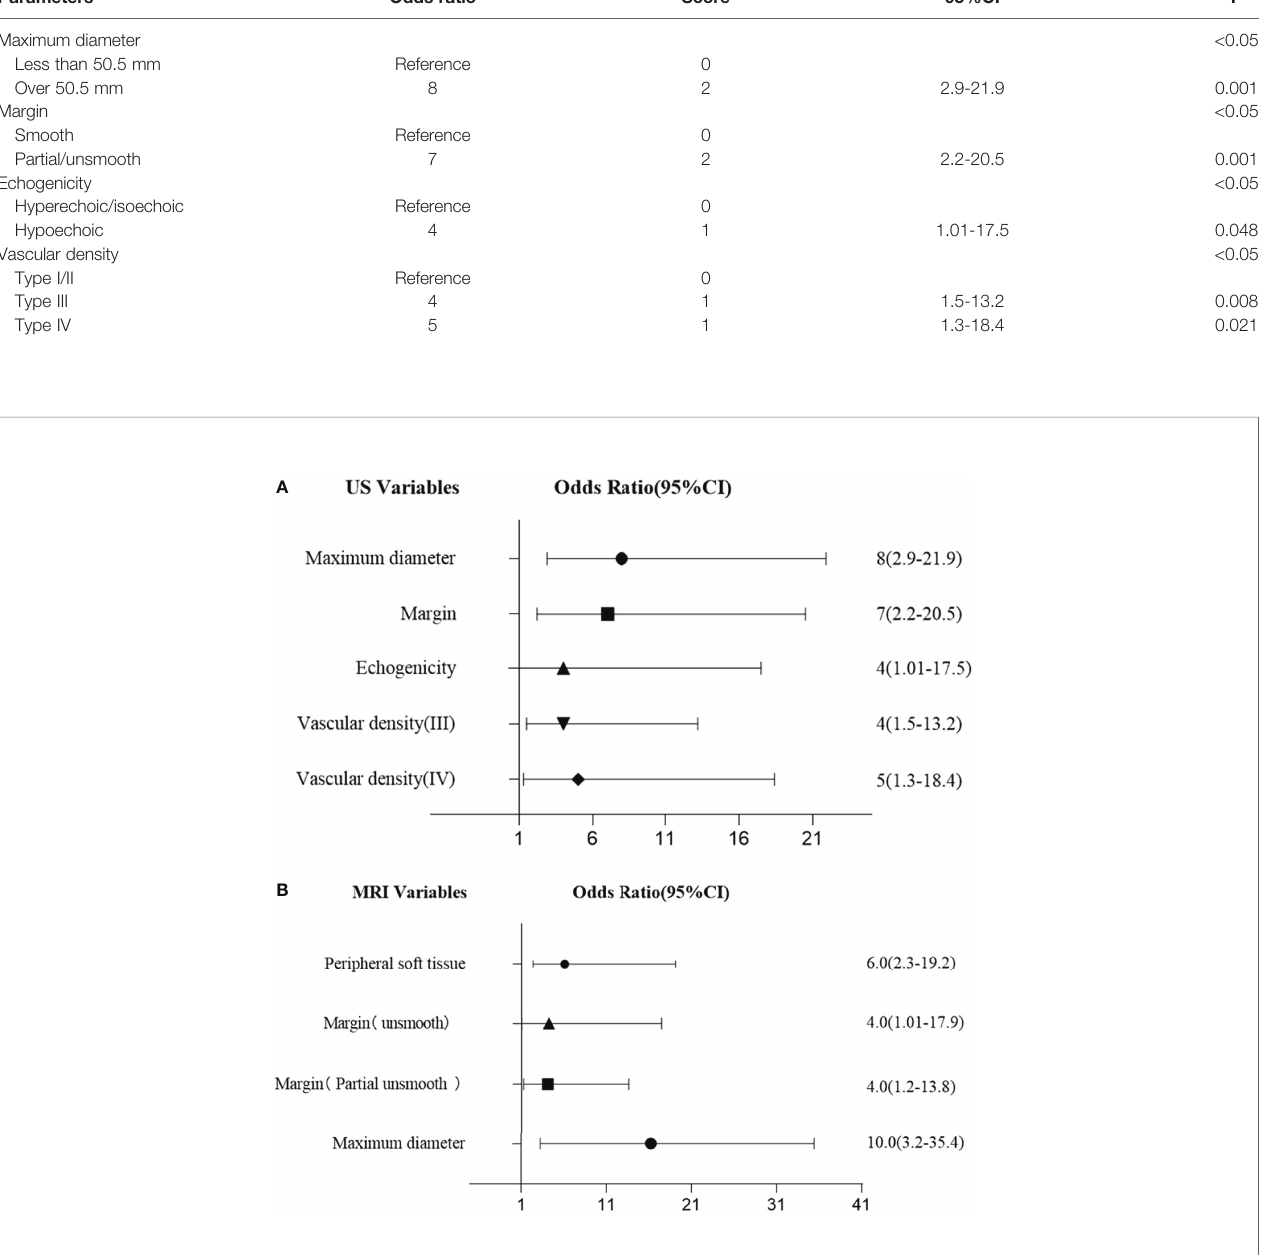
FIGURE 1 | (A) Multivariate logistic regression for US features. (B) Multivariate logistic regression for MRI features.